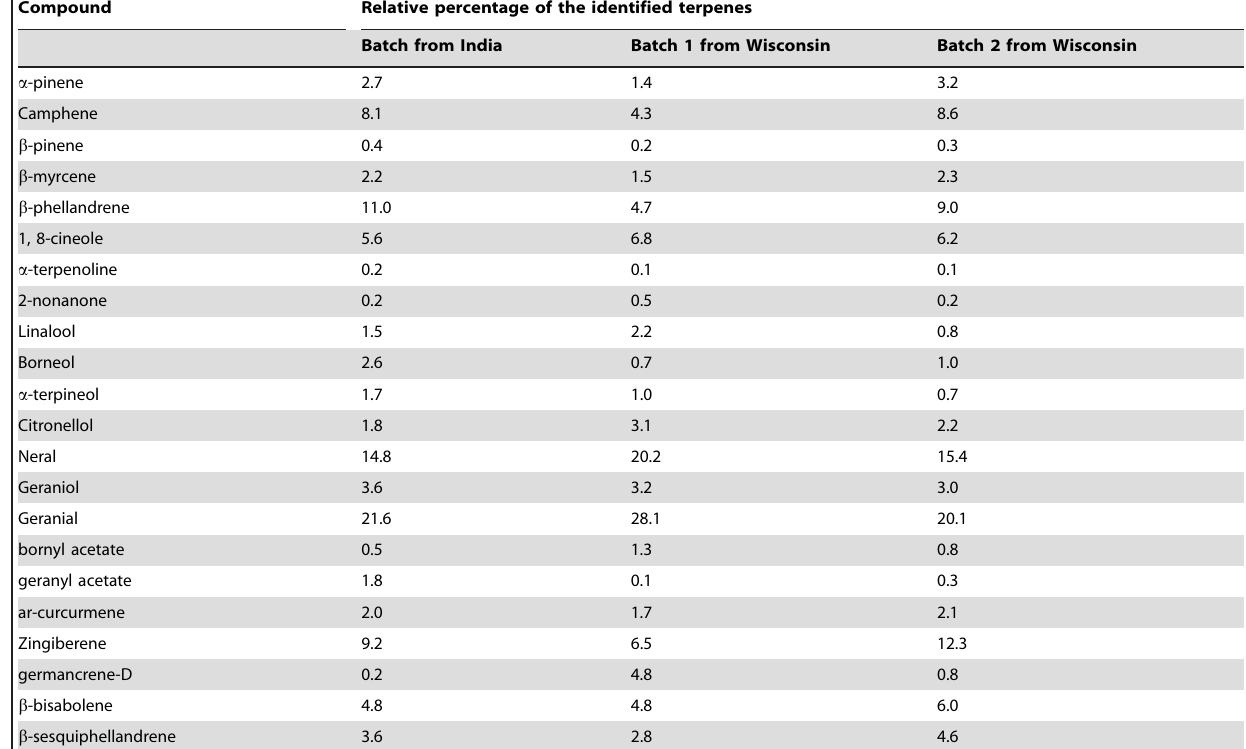
Compound Relative percentage of the identified